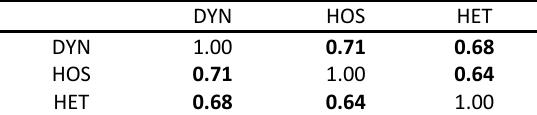
Table 4: Variable correlation coefficients determining the condition of the